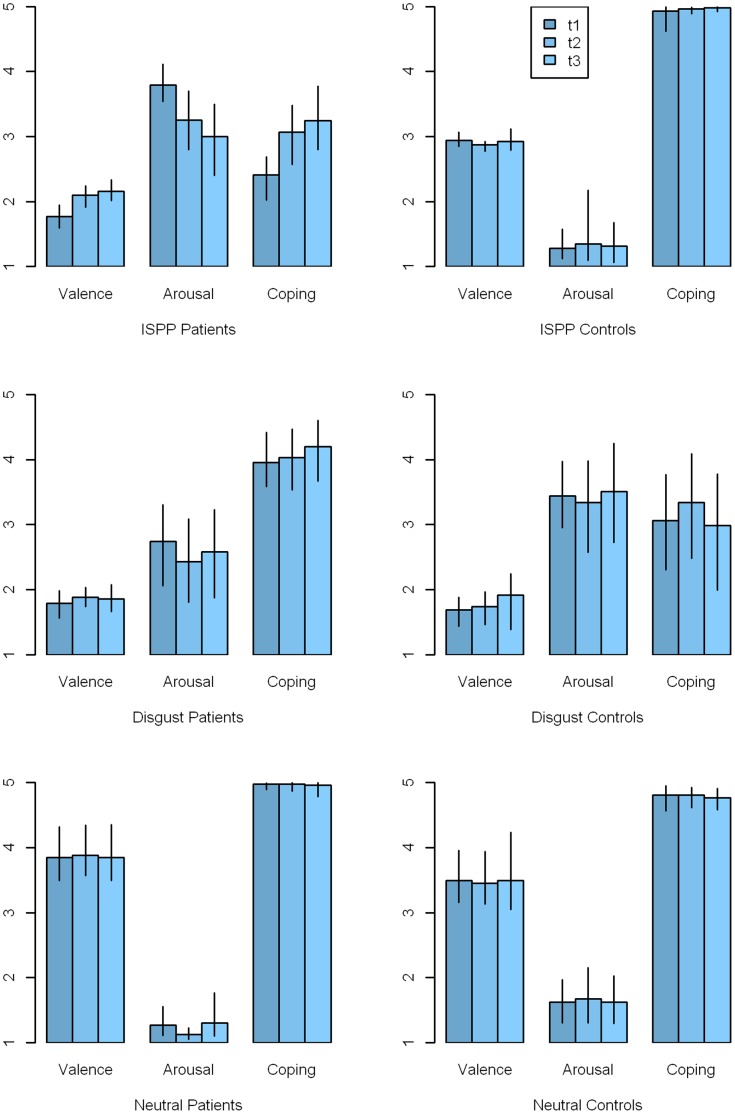
Ratings of stimulus material.Ratings for individualized symptom provoking pictures [a], IAPS disgust pictures [b], and IAPS neutral pictures [c]. Left: patients, right: healthy controls. Rating according to valence, arousal, and coping. The three adjacent columns represent the ratings of three successive fMRI scans. The fourth measurement taken for 2 patients and one control is not represented. 95% confidence intervals of the means were bootstrapped with R’s boot.ci function using 10.000 resamples and the “bca” type of confidence intervals.